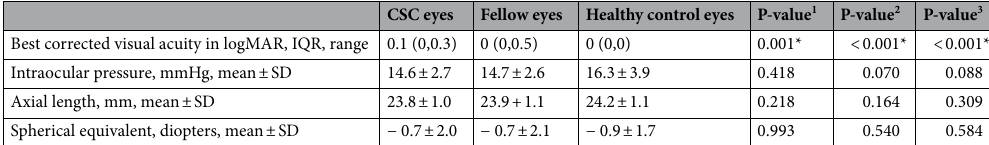
Table 2. Comparisons of parameters among CSC eyes, fellow eyes and healthy control eyes. CSC central serous chorioretinopathy, logMAR logarithm of the minimum angle of resolution, SD standard deviation. *Statistically significant. 1 Comparisons of ocular factors between diseased and fellow eyes of patients with CSC were performed using the paired t test for parameters with normal distribution and using the Wilcoxon matched-pairs signed rank test for parameters with nonnormal distribution. 2 Comparisons of ocular factors between healthy eyes and fellow eyes of patients with CSC were performed using the independent t test for parameters with normal distribution and using the Mann Whitney U test for parameters with nonnormal distribution. 3 Comparisons of ocular factors between healthy eyes and diseased eyes of patients with CSC were performed using the unpaired t test for parameters with normal distribution and using the Mann Whitney U test for parameters with nonnormal distribution.